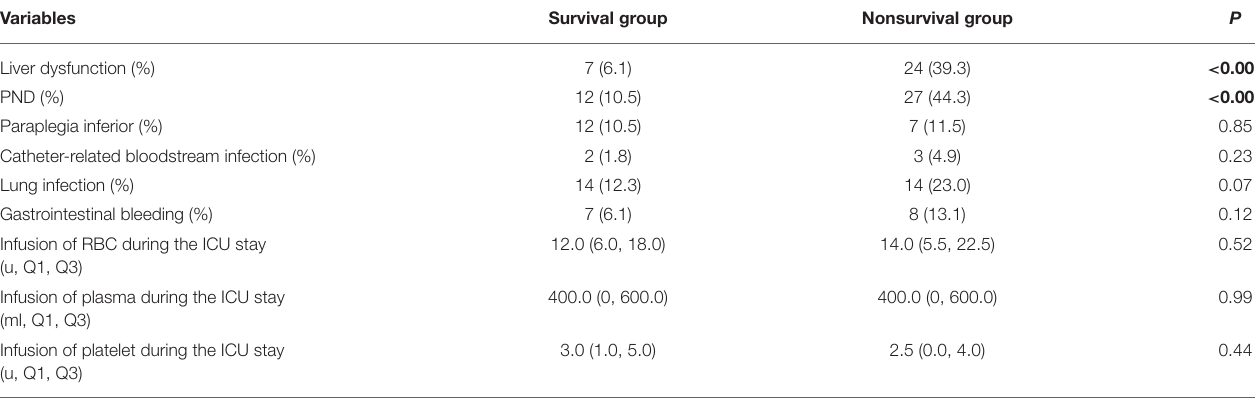
TABLE 4 | Postoperative complications and transfusion data during the ICU stay in the survival and nonsurvival groups.